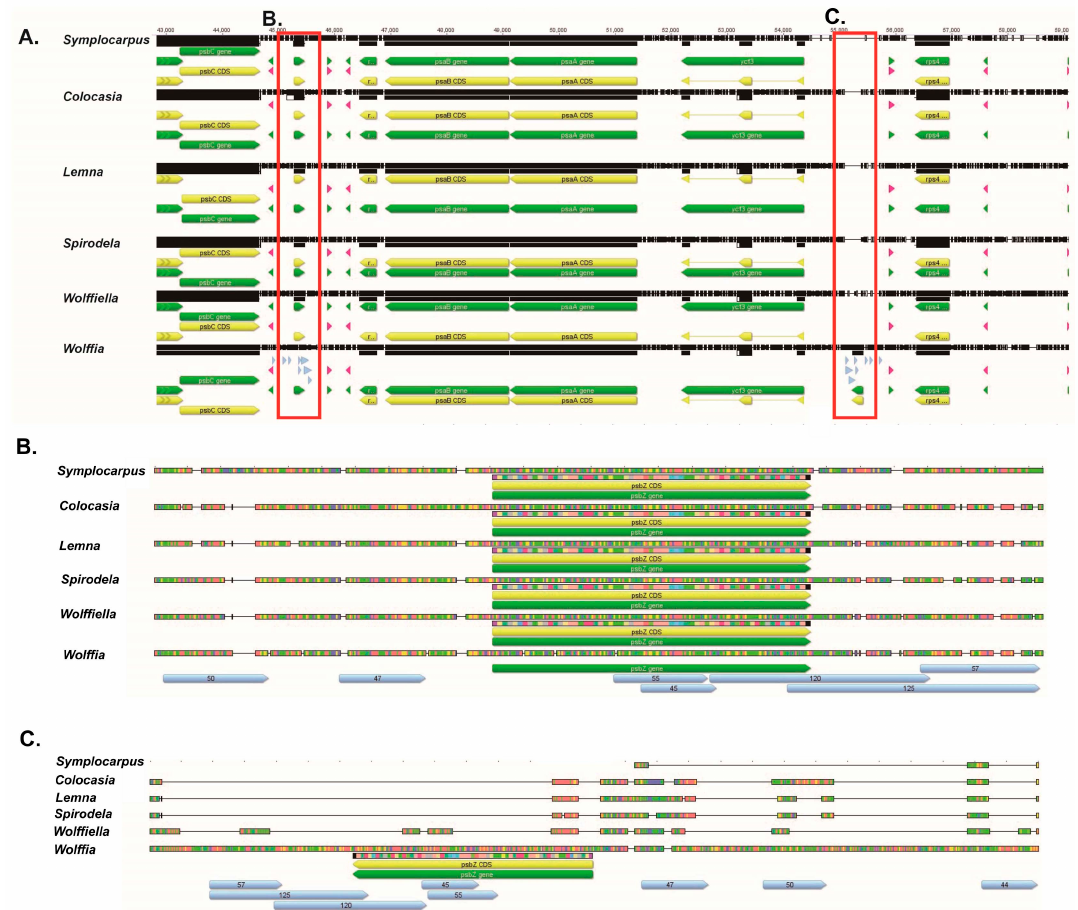
Figure 3. Comparison of psbZ in Araceae species. ( A ) Sequence of psbC - rps4 region; ( B ) Location of psbZ between trnS -UGA and trnG -UCC ( C ) Location of psbZ between ycf3 and trnS -GGA. Arrow indicates the tandem repeats.